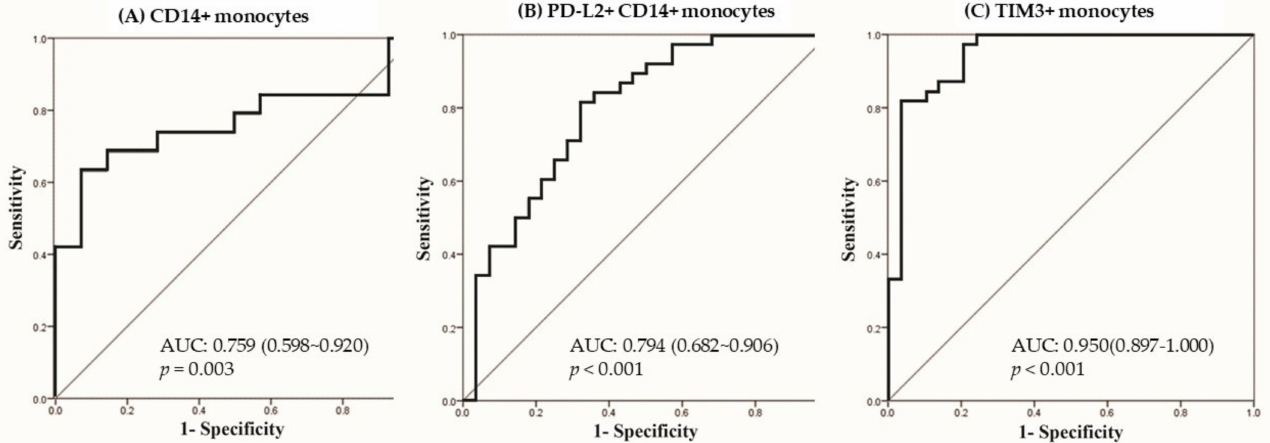
Figure 3. Receiver operating characteristic curves to predict latent tuberculosis infection (LTBI) of ( A ) total CD14+ monocytes among LTBI-non-CKD and healthy controls, ( B ) PDL2+ CD14+ monocytes, and ( C ) TIM3+ monocytes among healthy controls and LTBI-ESRD, using significant factors from multivariable logistic regression. The Youden index was applied to set a cut-off